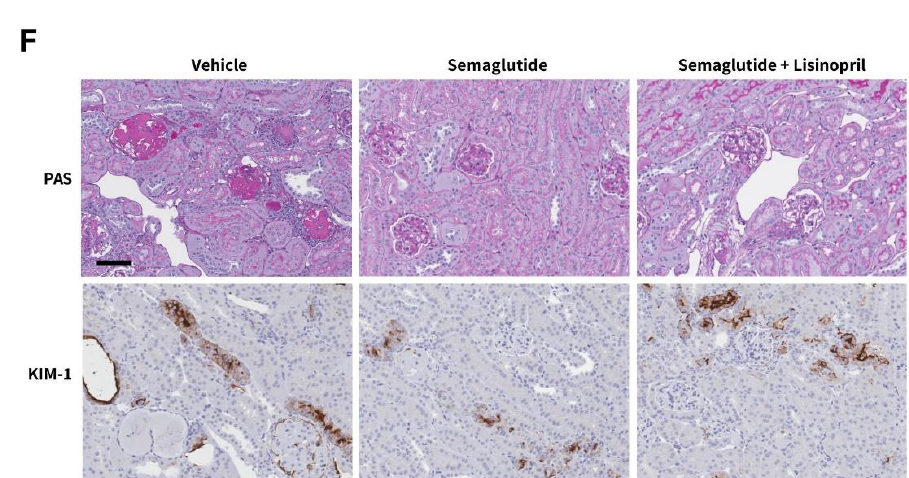
Figure 5. Semaglutide improves glomerulosclerosis in db / db UNx-ReninAAV mice. Automated AI-based detection of glomerulosclerosis in PAS-positive glomeruli in db / db UNx-ReninAAV mice re- ceiving (q.d.) vehicle, semaglutide (30 nmol/kg, s.c., n = 15) or semaglutide (30 nmol/kg, s.c., n = 15) + lisinopril (30 mg/kg, p.o., n = 14). ( A ) Group-wise distribution (fraction %) of glomerulosclerosis scores. ( B ) Glomerulosclerosis index. ( C ) Fraction of glomeruli with severe or global glomerulosclero- sis (GS3 + GS4). ( D ) Correlation of glomerulosclerosis index and albuminuria. ( E ) Fractional (%) area of whole-section kidney molecule-1 (KIM-1). ( F ) Representative photomicrographs from db / db UNx-ReninAAV mice receiving vehicle, semaglutide or combined semaglutide + lisinopril admin- istration. *** p < 0.001 vs. vehicle-dosed db / db UNx-ReninAAV mice; ### p < 0.001 vs. semaglutide (Dunnett’s test one -factor linear model with interaction). Scale bar, 100 µm.